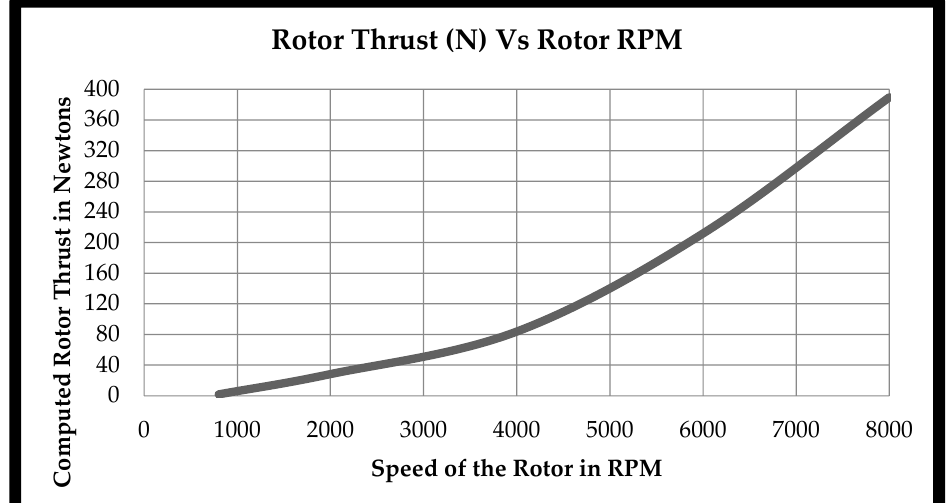
Figure 49. Comprehensive outcomes between rotor thrust and rotor RPM.